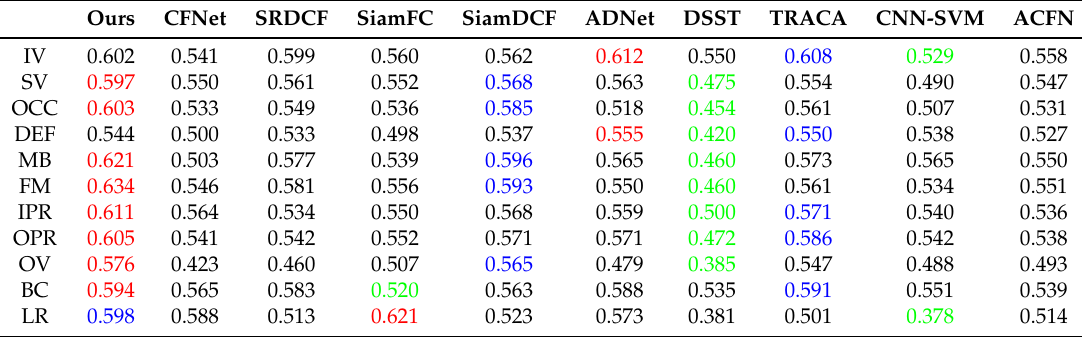
Table 3. Average area under curve (AUC) scores of the 10 trackers in terms of different attributes: The top three results are shown in Red, Blue, and Green.